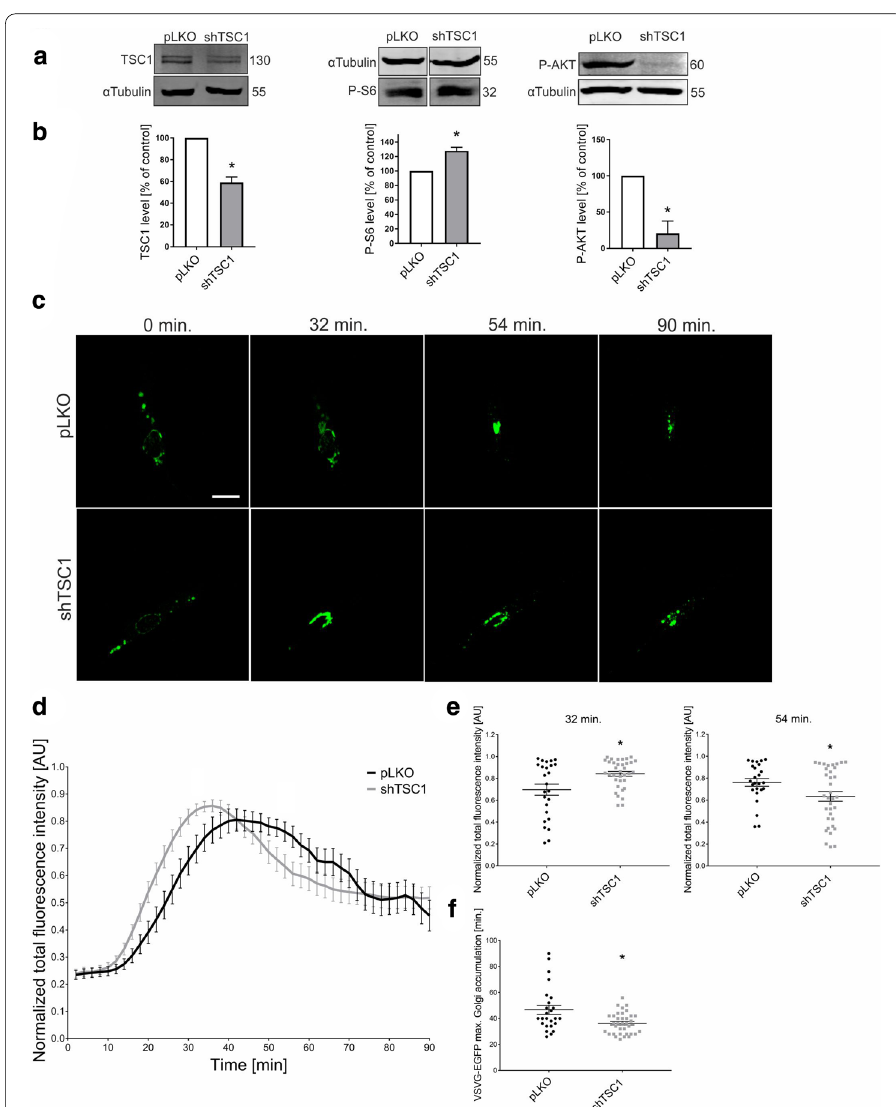
Fig. 4 ER-to-GA VSVg trafficking is affected in human fibroblasts with TSC1 knockdown. a Western blot analysis of TSC1, phospho-S6 (P-S6), and phospho-AKT (P-AKT) levels in protein lysates from control pLKO and shTSC1 fibroblasts. b Quantification of Western blot analysis of hamartin, P-AKT, and P-S6, normalized to tubulin, in protein lysates that were obtained as in ( a ). * p < 0.05 (one-sample t -test). N experiments. c Representative time-lapse confocal images of living fibroblasts: control (pLKO) and with TSC1 knockdown (shTSC1). The fibroblasts were electroporated with Str-li_VSVGwt-SBP-EGFP. Trafficking of VSVg-EGFP was visualized using the RUSH assay for 90 min after the addition of biotin (time 0). Scale bar 20 µm. d Quantitative analysis of the experiments performed as in ( c ). The graph presents VSVg-EGFP = fluorescence intensity in the Golgi apparatus region at each time point, normalized to the maximum value. The data are expressed as the mean for all of the analyzed cells. Error bars indicate SEM. N experiments. Number of cells per variant ( n ): pLKO (25), shTSC1 (35). e Comparison of VSVg-EGFP fluorescence intensity in the Golgi apparatus region at 32 min (left panel) and 54 min (right panel). The data are expressed as the mean for all of the analyzed cells. Error bars indicate SEM. * p < 0.05 (Mann–Whitney test). The number of independent experiments and analyzed cells per variant are the same as in ( d ). f Comparison of VSVg-EGFP maximum accumulation times in the Golgi apparatus region. The data are expressed as the mean for all of the analyzed cells. Error bars indicate SEM. * p < 0.05 (Mann–Whitney test). The number of independent experiments and analyzed cells per variant are the same as in ( d